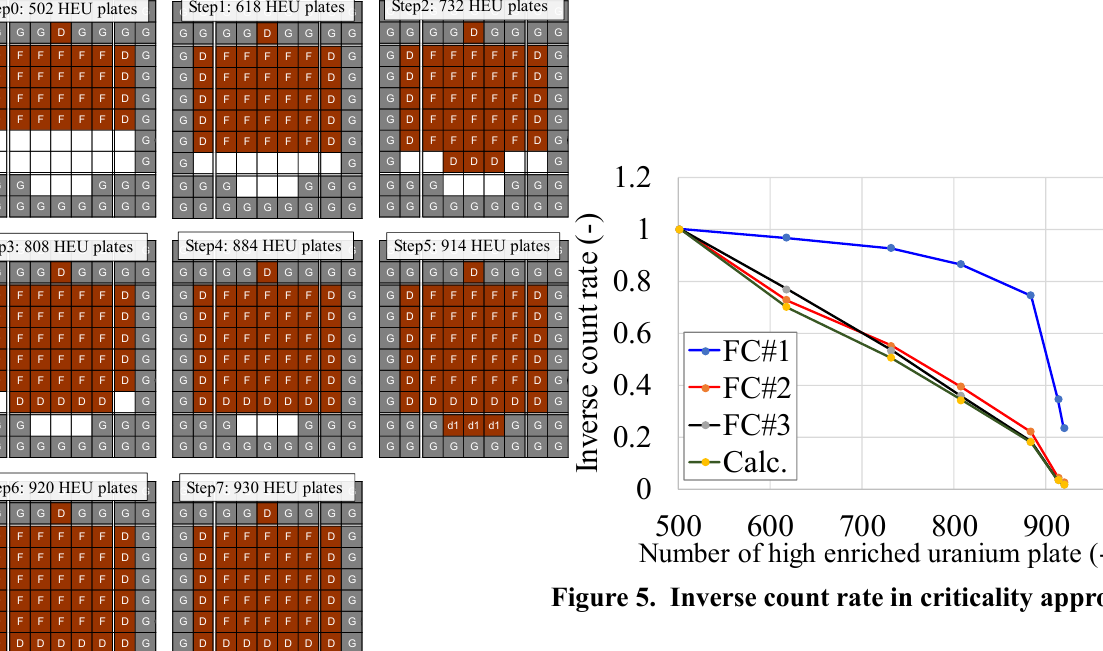
Figure 5. Inverse count rate in criticality